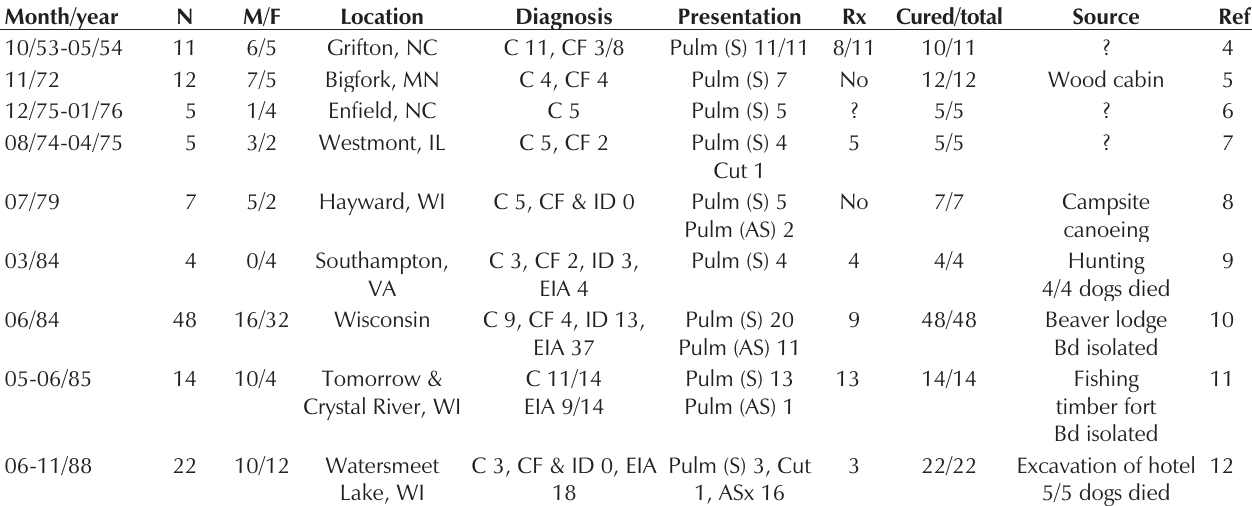
TABLE 1 Summary of nine outbreaks of blastomycosis: